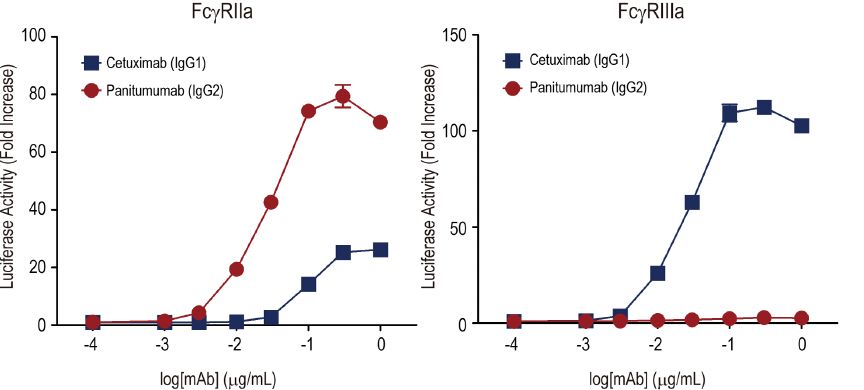
Figure 3. Activation of Jurkat/Fc c R/NFAT-Luc cells by EGFR-bound cetuximab and panitumumab. A431 and Jurkat/Fc c R/NFAT-Luc cells were co-cultured in the presence of serially diluted cetuximab (IgG1 subclass) or panitumumab (IgG2 subclass). The luciferase activity (i.e., the fold increase compared to the control sample without mAbs) is represented on the graphs. The assays were performed in triplicate, and the data are the mean 6 SEM. Panitumumab activated Jurkat/Fc c RIIa/NFAT-Luc cells more strongly than cetuximab (p , 0.0001, Graphpad Prism Software).